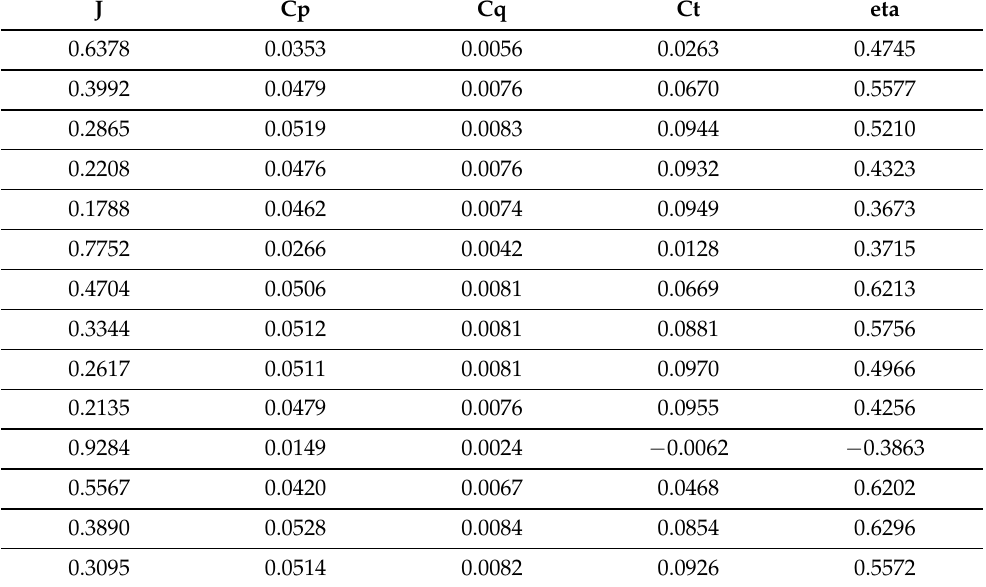
Table A15. APC 18 × 14 propeller wind tunnel processed